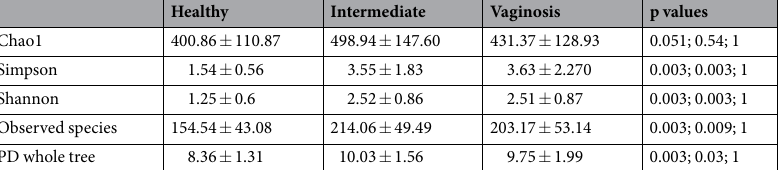
Table 1. Comparison of bacterial diversity between cohorts. Bacterial diversity values are given as the mean ± standard deviation at a rarefaction depth of 10,000 sequences per sample. Alpha diversity was compared between groups by means of a non-parametric t-test using the compare_alpha_diversity.py script of QIIME. The p values are shown in the last column in the following order: Healthy vs Intermediate, Healthy vs Vaginosis, and Intermediate vs